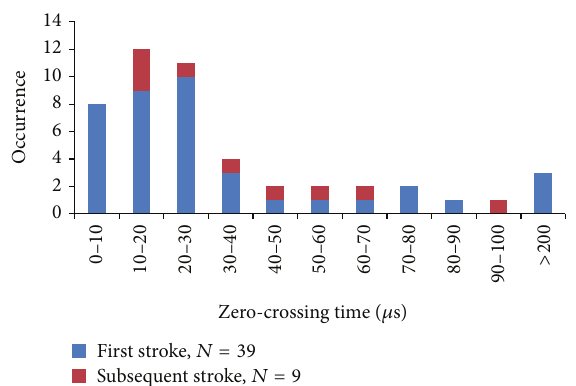
Figure11:Histogramsofoppositepolarityovershootrelativetopeak for 48 positive return